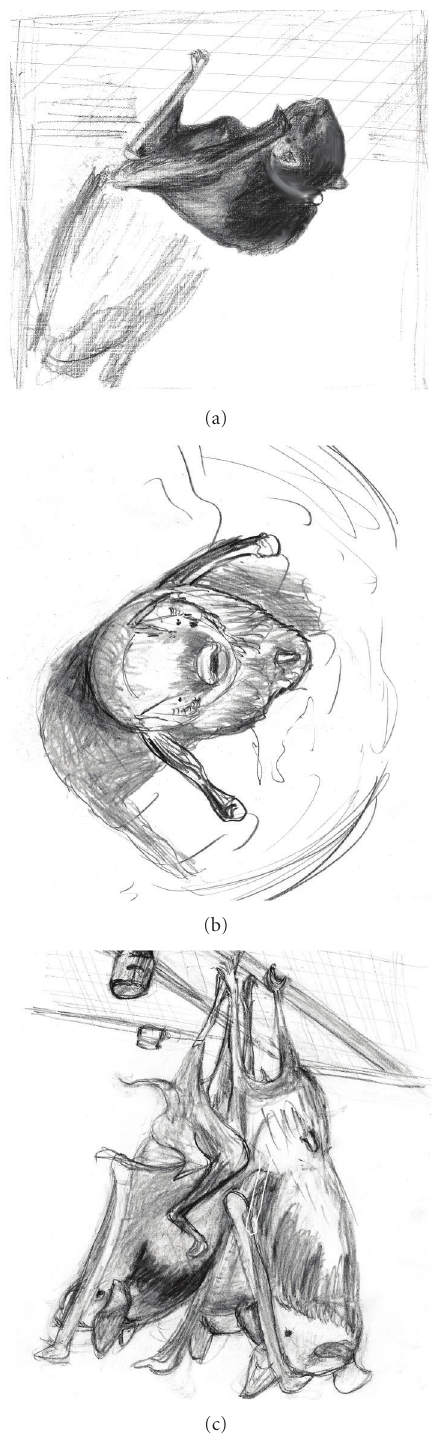
Figure 3: Drawings of individuals, traced from images acquired with an infrared camera showing common postures that are not typically associated with any vocalizations. Adapted from [26]. (a) Crouching. (b) Marking with hip thrust forward. (c) Three bats hanging with their backs in contact as the one on the left grooms it